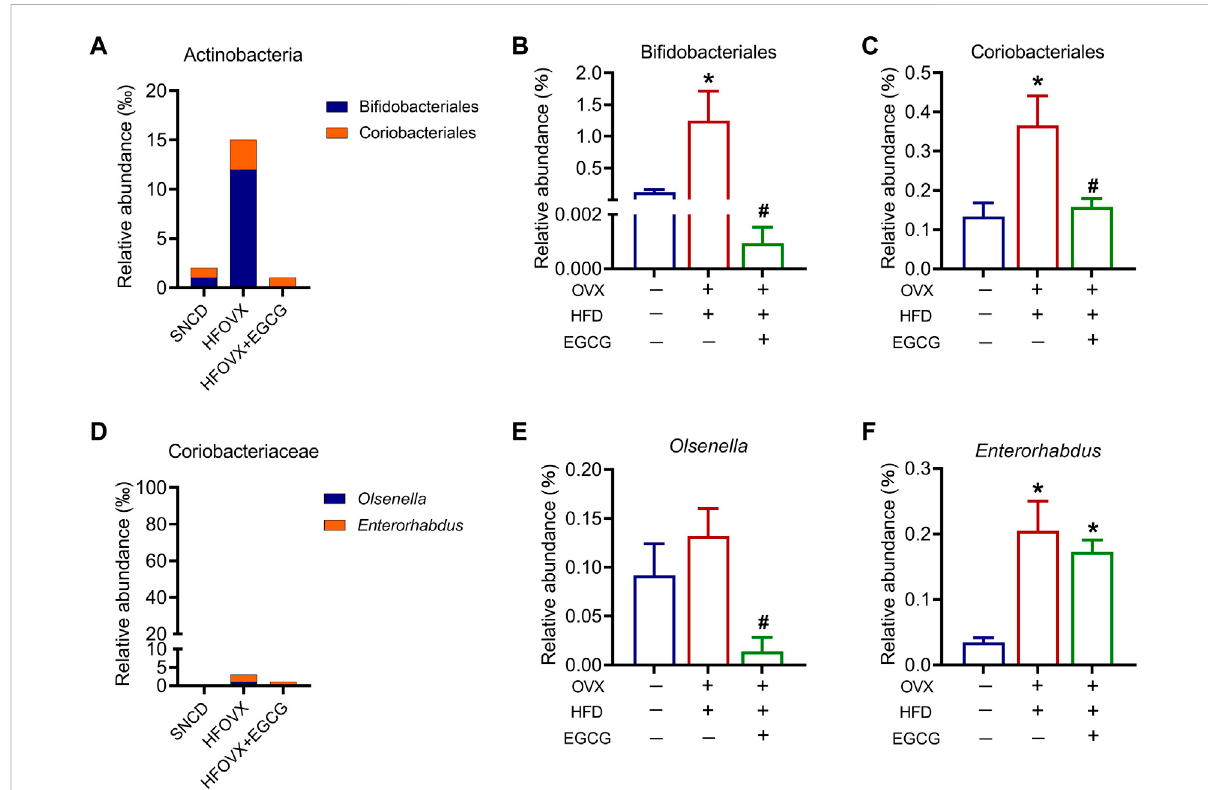
FIGURE 5 Effects of EGCG on the relative abundance of Actinobacteria in HFOVX mice. (A) Species pro fi ling histogram of the relative abundance of the Actinobacteria community structure in each group, including Bi fi dobacteriales (B) and Coriobacteriales (C) . (D – F) Relative abundance of the Coriobacteriales (D) , Olsenella (E) ,and Enterorhabdus levels (F) inSNCD,HFOVXandHFOVX+EGCGmice.* p < 0.05,HFOVXgroupvs.SNCDgroup, or HFOVX + EGCG vs. SNCD group; # p < 0.05 HFOVX + EGCG vs. HFOVX group; n = 6 – 7